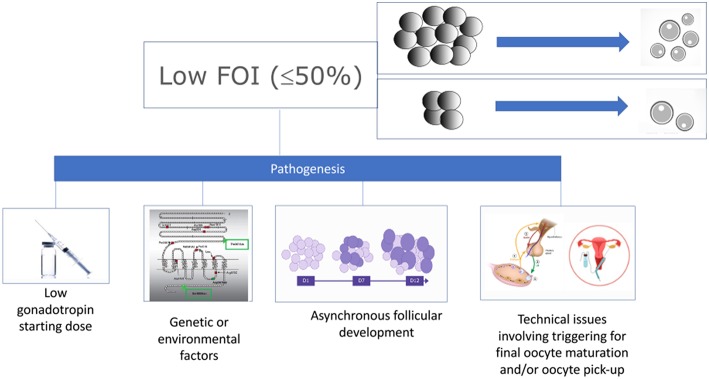
Pathogenesis of low follicle-to-oocyte index (FOI). Reprint from Alviggi et al. (17).